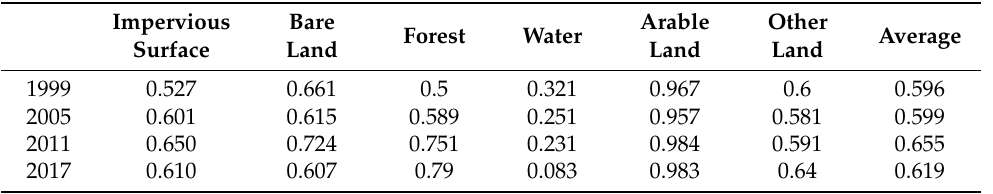
Table 4. Urban density resilience index of each landscape of Mianyang.